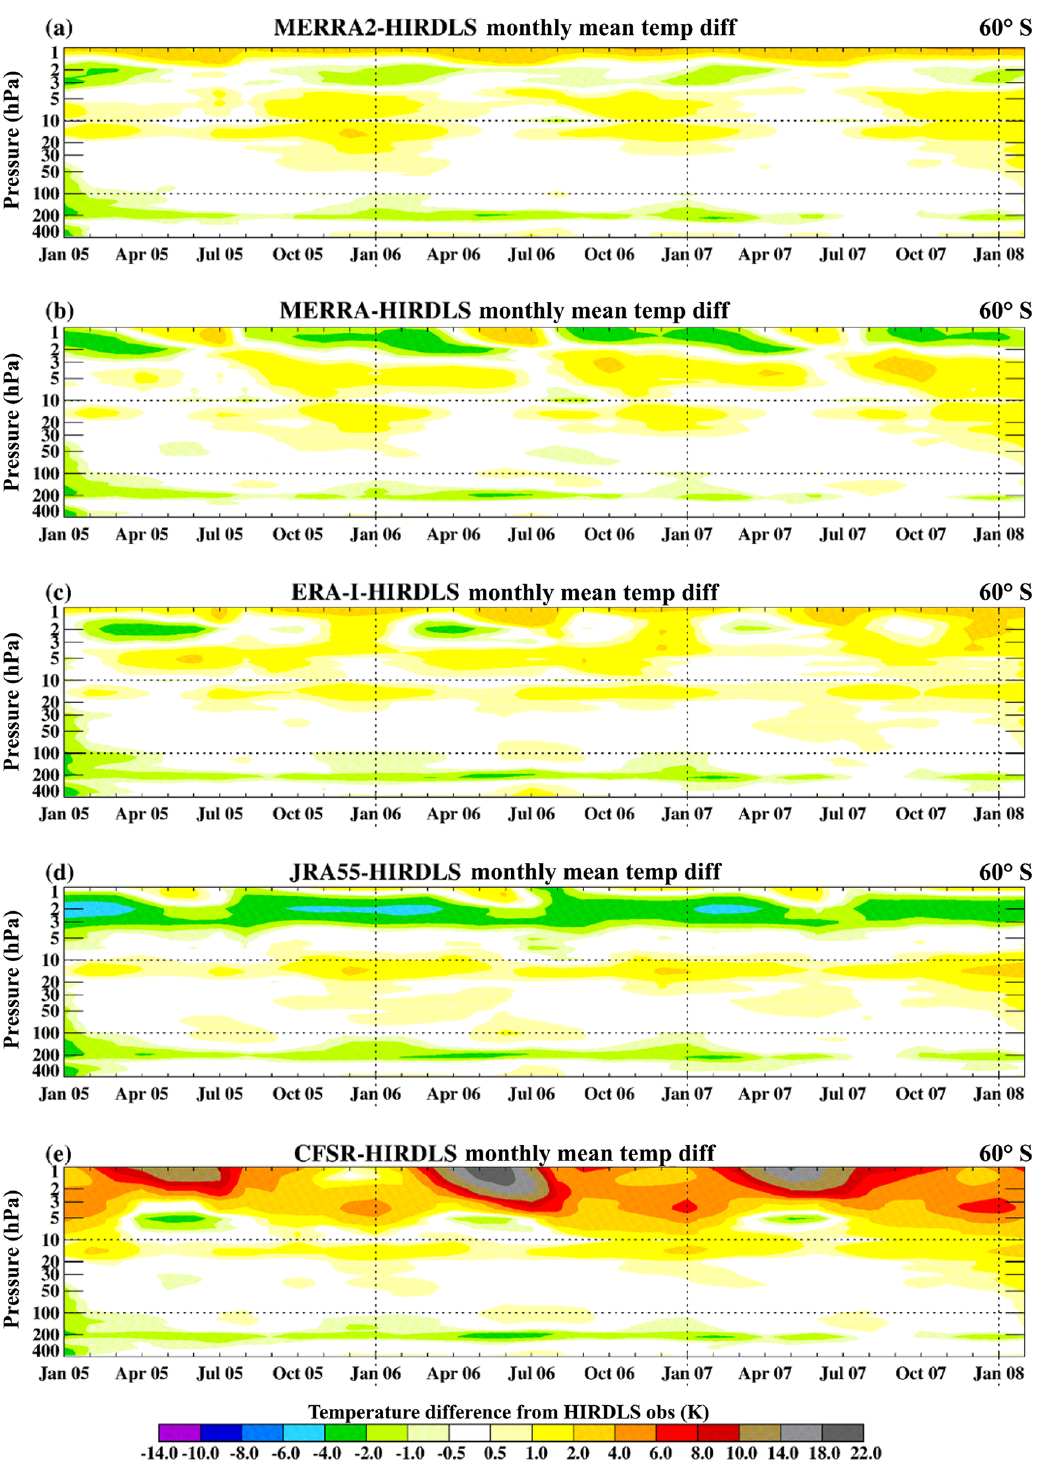
Figure 12. Pressure vs. time plots of differences in reanalyses minus HIRDLS temperatures (K) from January 2005 through January 2008 for the Southern Hemisphere high-latitude zone (60 ◦ S). The reanalyses are (a) MERRA-2, (b) MERRA, (c) ERA-I, (d) JRA-55, and (e)